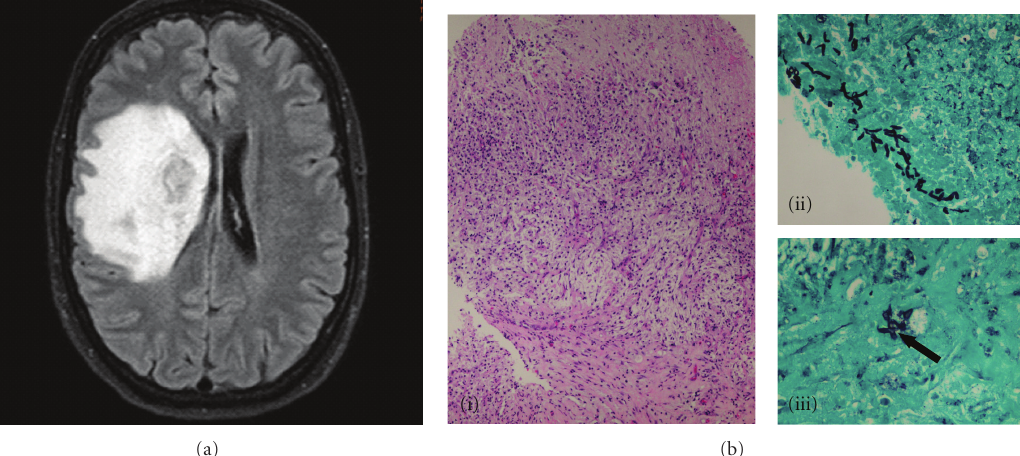
Figure 2: (a) FLAIR axial sequence of MRI of brain with gadolinium showing a large lesion in the right basal ganglia and frontal lobe with extensive edema and mass e ff ect in keeping with a fungal abscess. (b) Brain biopsy (i). Representative area of the brain biopsy shows relatively acellular necrotic material in the top 1/5 of the image, the dense pink well-formed capsule, of a chronic abscess, occupying the bottom 1/3 of the image and a looser admixture of lymphocytes, macrophages, and new blood vessels in the center of the field. Hematoxylin and eosin, original magnification 100x (ii). The dark black structures forming a linear array running obliquely from top left to bottom center are fragments of fungi. Gomori Methenamine Silver, original magnification 400x (iii). The arrow indicates a single black fragment of a fungal structure with 45-degree branching, which is characteristic of aspergillus. Gomori Methenamine Silver, original magnification